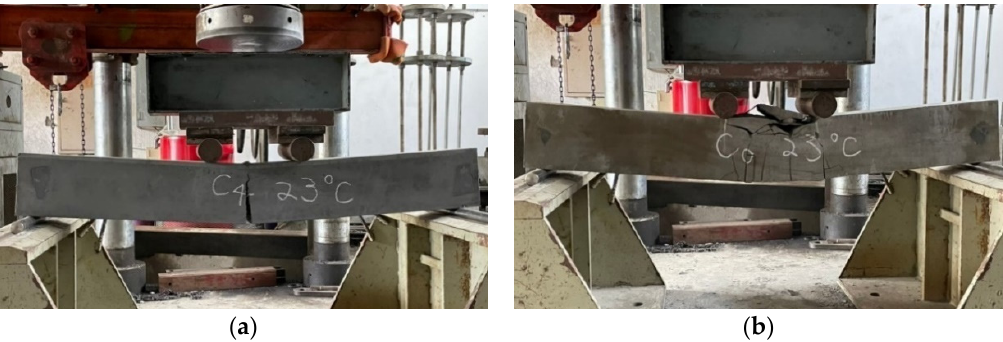
Figure 10. The tensile failure in the flexural test of beam at room temperature: ( a ) the experimental group and ( b ) the control group. Table 8. The flexural load of the beams at room temperature and after thermal exposure.